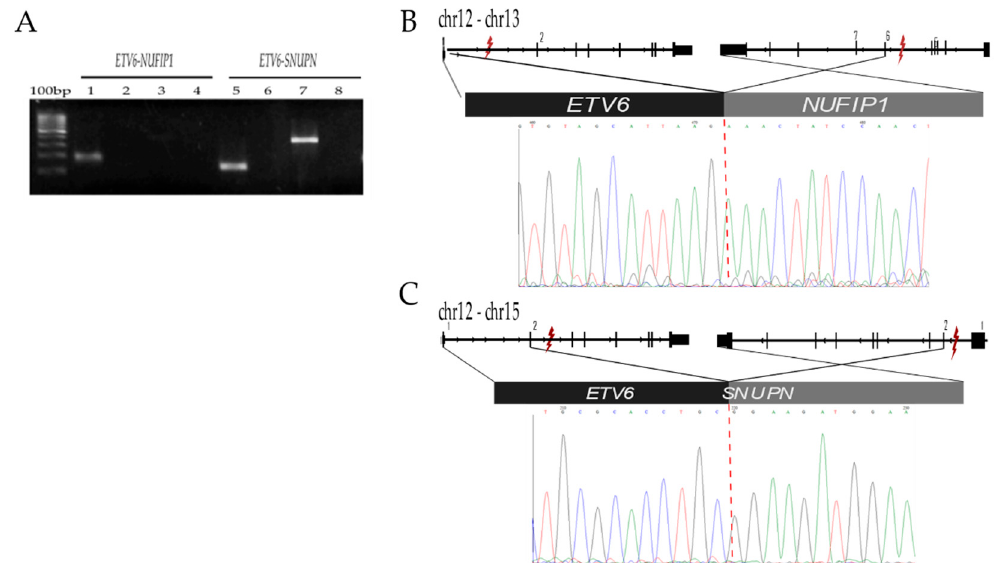
Figure 3. Identification of the ETV6 gene fusion transcript. For ETV6 fusion confirmation, the original RNA sample was used. Primers were designed to amplify ETV6 - NUFIP1 with the two regions of 118 bp and 269 bp named internal and external, respectively. For ETV6 - SNUPN, two regions, 112 bp-internal and 339 bp-external, were also amplified (Table S1). ( A ) 100 bp marker, RT-PCR of ETV6 - NUFIP1 with primers ETV6-NUFIP1-int (lane 1), with primers ETV6-NUFIP1-ext (lane 3). RT-PCR with primers